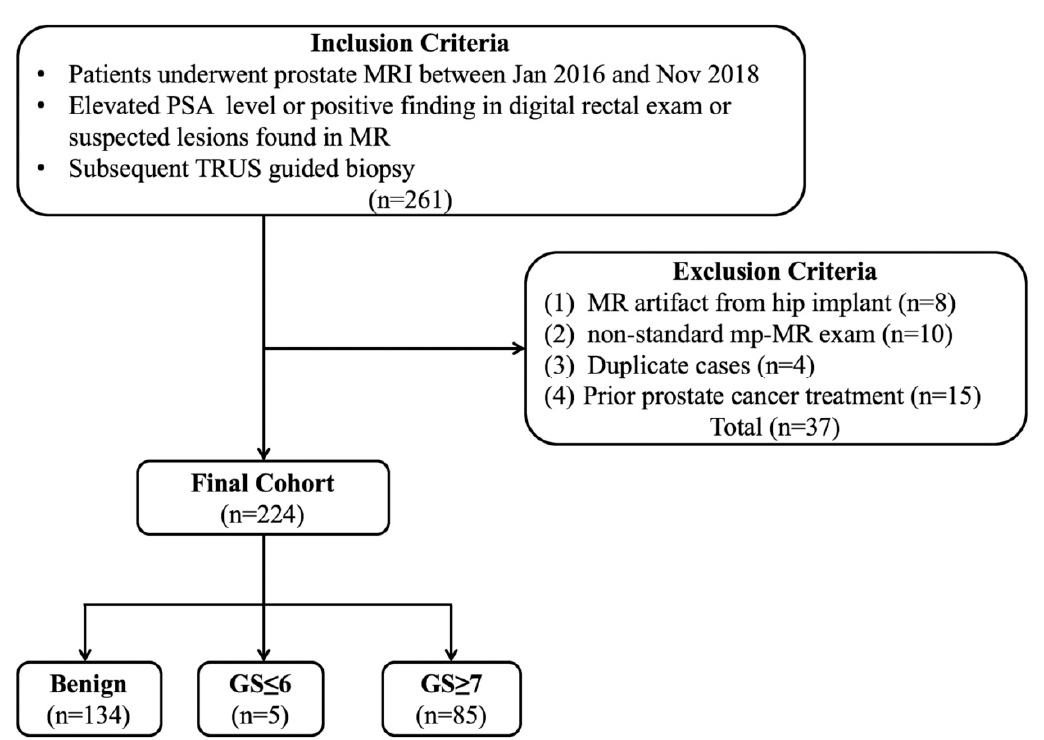
Figure 1. Flowchart of the study population. Note: TRUS—transrectal US; PSA—prostate-specific antigen.